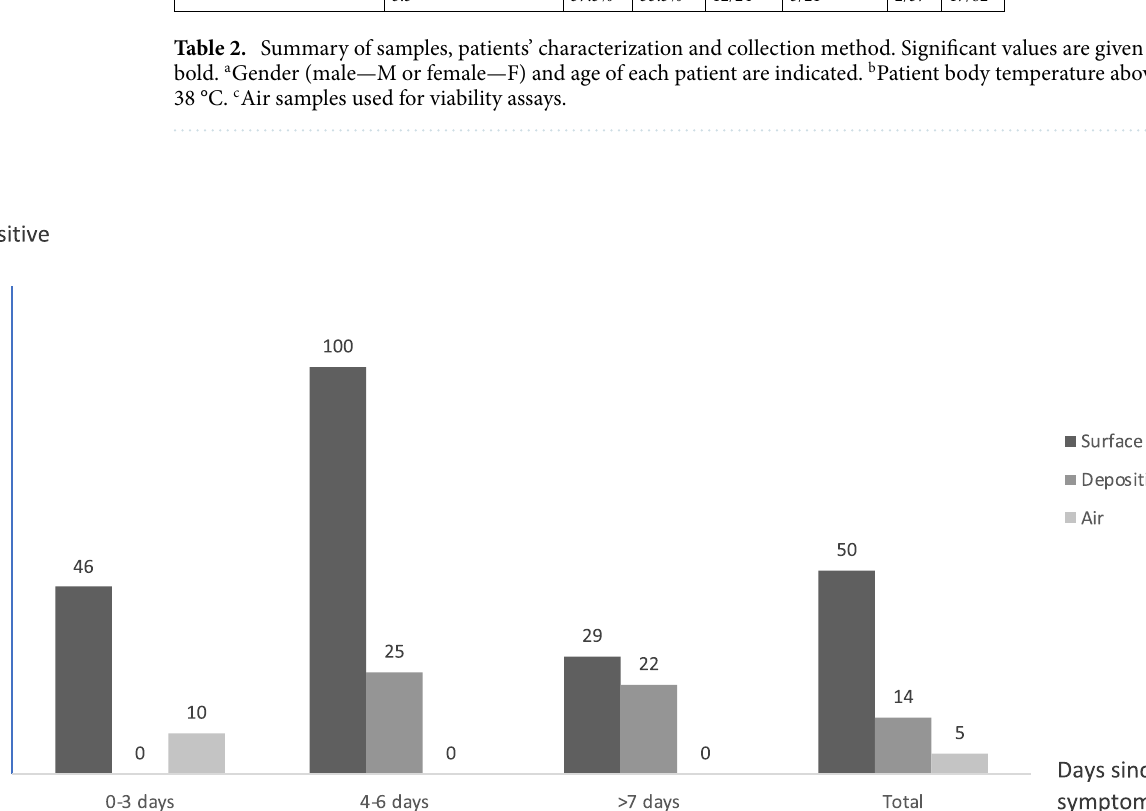
Figure 2. Distribution of total positive samples from the spaces studied according to the number of days after onset of